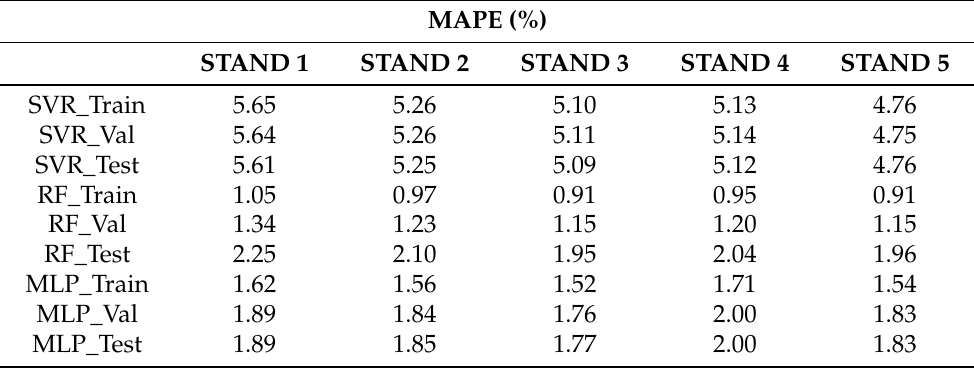
Table 16. Comparison with a baseline of machine learning methodologies for roll force prediction using MAPE.